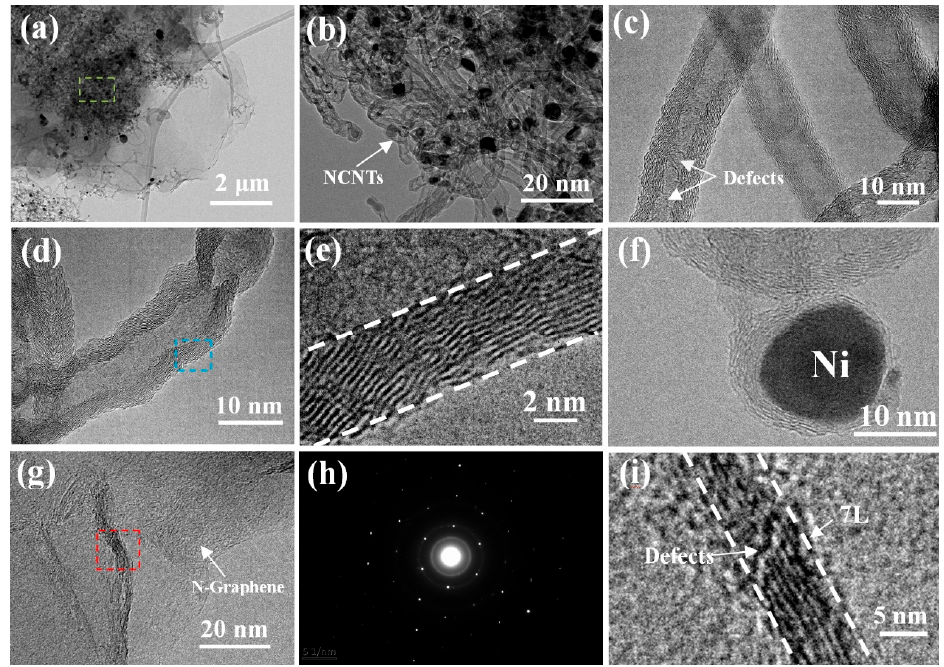
Figure 4. ( a ) TEM image of N-CNTs/N-graphene structure; ( b ) HRTEM images about N-CNTs taken from the box in ( a ); ( c ) TEM image of defects in the N-CNTs; ( d , e ) HRTEM of the single multiwall N-CNT; ( f ) The mental catalyst on the tip of N-CNTs; ( g , h ) The TEM image and the selected electron diffraction pattern (SAED) of N-graphene, respectively; ( i ) Shown the number of wall of N-graphene in ( g ).